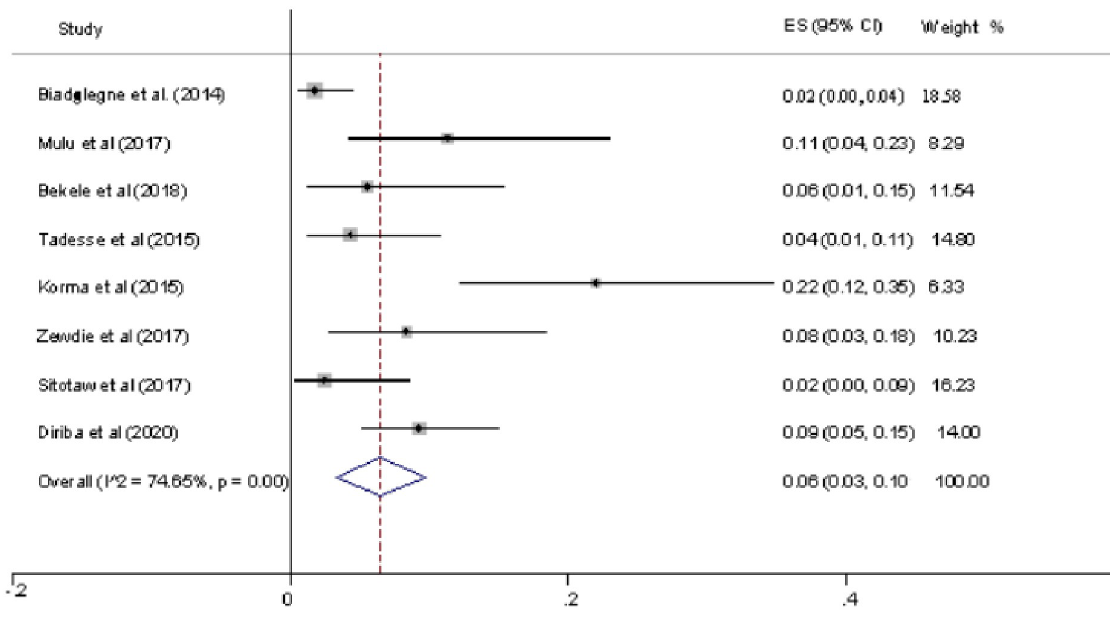
Fig 2. Forest plot showing the prevalence of RIF among the total